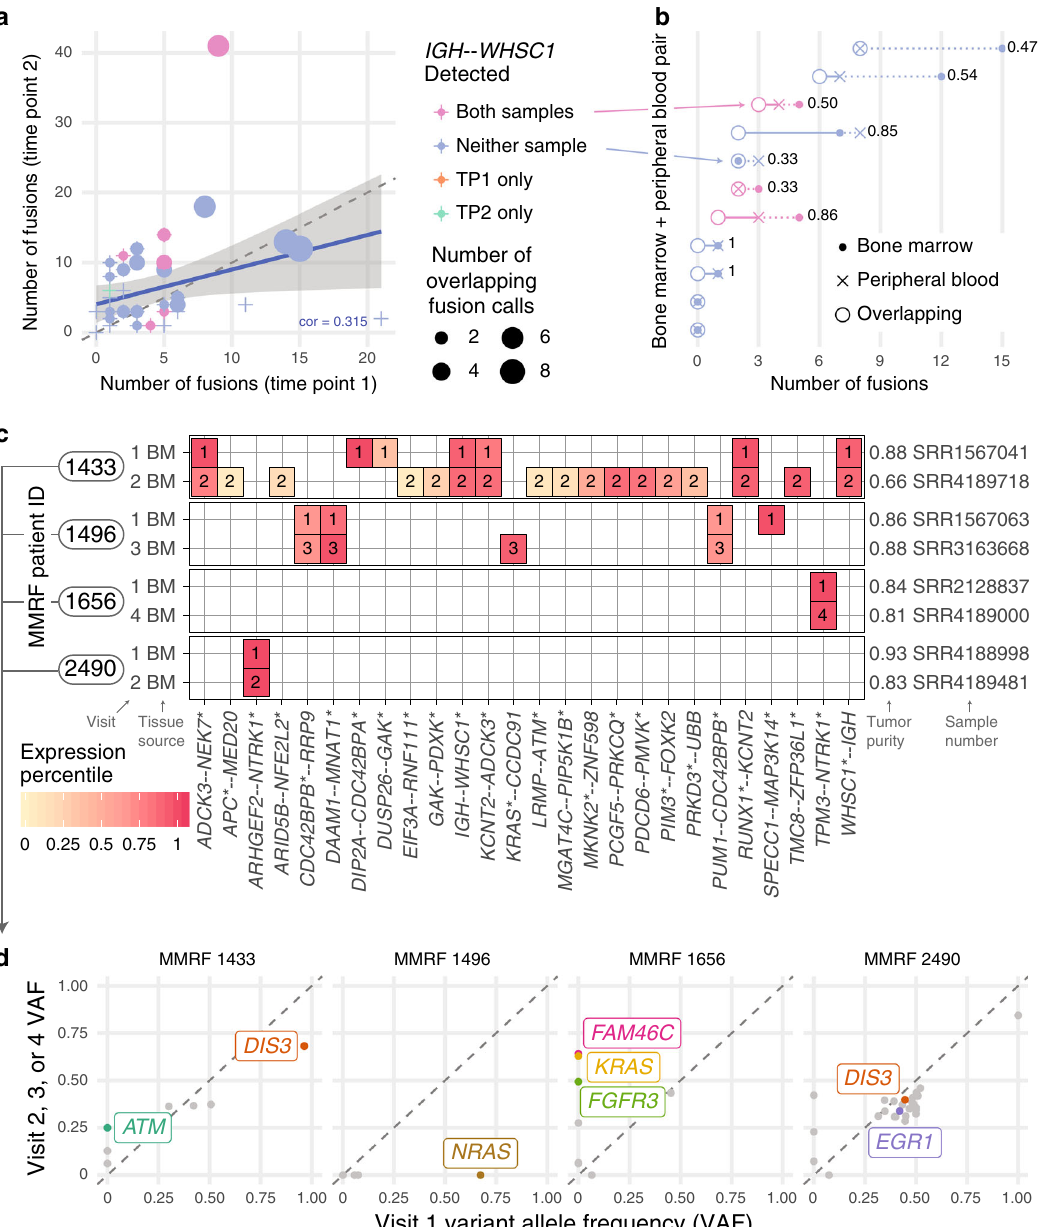
Fig. 3 Fusions detected from multiple clinical samples and fusion evolution. a Number of fusions called at serial clinic visits. Shaded region indicates a 95% con fi dence interval on the regression line. b Overlap of fusions called from bone marrow (BM) and peripheral blood (PB) from the same clinic visit with normalized Hamming distance (range 0 – 1, 0 = perfect overlap, 1 = completely discordant). c Fusions from cancer-related genes detected at serial clinic visits. d Somatic mutations from cancer-related genes detected at serial clinic visits. Genes frequently mutated in multiple myeloma are labeled. Source data and scripts are available at https://doi.org/10.6084/m9. fi